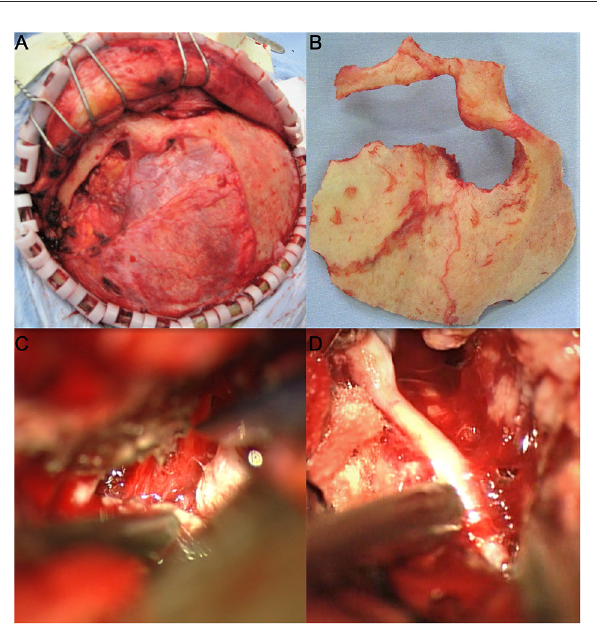
FIGURE2 Adoption of the left frontotemporal–orbitozygomatic approach and intradural and epidural combination approach. One incisura was created on the trailing edge of the zygomatic process of the right frontal bone and two holes (outside the left orbit and on the left zygomatic arch) were drilled at the root of the left zygomatic arch to form a shape of ∼ 8 × 10cm with the bone flap. The anterior part of the bone flap was parallel to the anterior and central skull base. During surgery, the tumor base was found to originate from the left ACP and involve the lateral wall of the left cavernous sinus. The sphenoid ridge was first removed epidurally under the endoscope, and the medial side of the sphenoid ridge was removed to the extent possible. Then, the tumor was resected in blocks intradurally, while the tumor base was dissected. After the tumor was sufficiently decompressed, the ACP with hyperostosis was removed epidurally, and the optic canal was opened. The tumor was resected in sequence, in steps, and in blocks, intradurally. It was first separated from the anterior skull base and the left sphenoid ridge; then the first gap was opened, and the cerebrospinal fluid was released from the second gap on the right side to alleviate tension in the brain tissue. The tumor base was dissected from the left central skull base. It had invaded the superior petrosal sinus from the posterior and grown beyond the left petrosal ridge toward the left tentorium. It had also encased the middle cerebral artery and anterior cerebral artery. The tumor was then separated under the endoscope. It had squeezed posteriorly into the cerebral peduncle and compressed the ipsilateral cerebral peduncle to shift to the opposite side. It had completely invaded the cavernous sinus and the central skull base. It was resected under the endoscope in blocks. The dura mater of the central skull base was electro-coagulated, and the lateral wall of the left cavernous sinus was partially cut off to free part of the tumor in the cavernous sinus. The left oculomotor nerve and the trigeminal nerve’s ophthalmic, maxillary, and mandibular branches were protected during surgery. The tumor in the cavernous sinus was also separated in steps and removed after electrocoagulation, and the bleeding in the cavernous sinus was stopped by gelatin sponge compression. (A) Adoption of the frontotemporal–orbitozygomatic approach; (B) orbitozygomatic bone flap; (C) intradural dissection of the ACP tumor base between the lateral side of the optic nerve and the internal carotid artery in the superior segment of the clinoid process; (D) the combination of antegrade and retrograde techniques used during surgery to dissect, separate, and protect the middle cerebral artery.